Question: How would you classify this visualization?
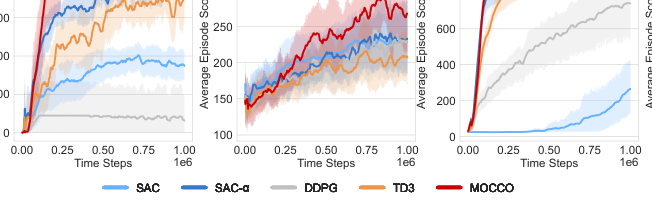
Answer: line